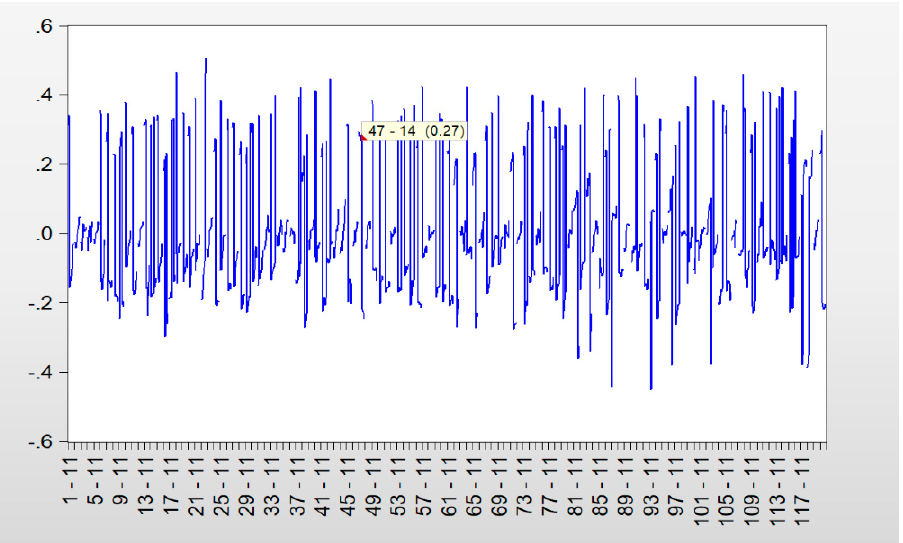
Figure 3. The influence of competitiveness and voting rights of major shareholders on the quality of corporate boards before the COVID-19 pandemic. Source: Author’s computations.